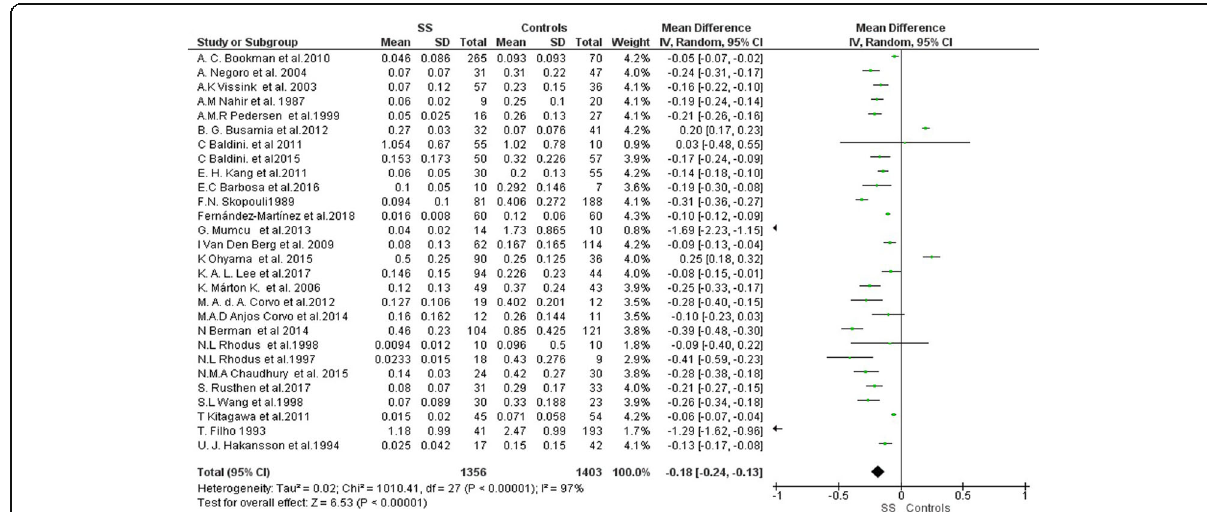
Fig. 2 Forest plot (random-effects model Mean Differences) of the unstimulated whole salivary flow rate in patients with Sjögren ’ s Syndrome compared to controls (healthy subjects and patients with sicca non-SS). This forest plot summarizes the results of studies evaluating the unstimulated whole salivary flow rate in patients with Sicca symptoms (SS vs controls). The numbers on the x-axis measure mean difference. The small green boxes represent the point estimate of the effect size and sample size of each study. The black lines on either side of the box represent a 95% confidence interval. The solid vertical line represents a mean difference of 0 or no effect. The overall pooled mean difference and 95% CI is indicated by a diamond at the bottom. Names of the first author ’ s studies are shown on the left. CI: Confidence Interval; df: degree freedom; Chi2: chi-squared test; I2: Higgins heterogeneity test; SD: Standard deviation; SS: Sjögren ’ s